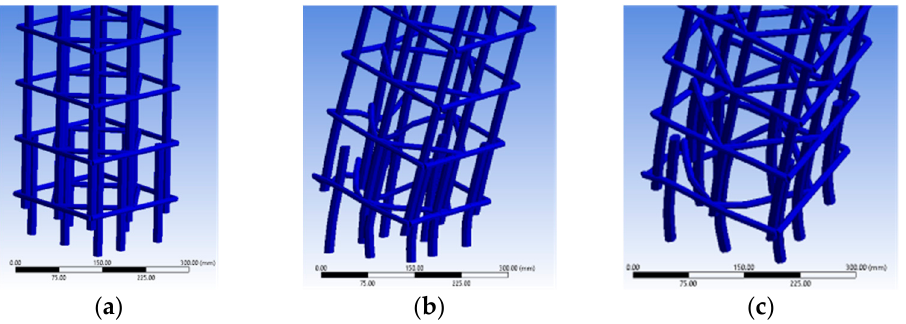
Figure 12. ( a ) Specimen A1F with 11 d bL lap length undeformed; ( b ) Slippage of longitudinal steel bars of specimen A1F at ultimate displacement 101.5 mm; ( c ) Specimen B2 at ultimate displacement 81.4 mm (magnification factor 5).